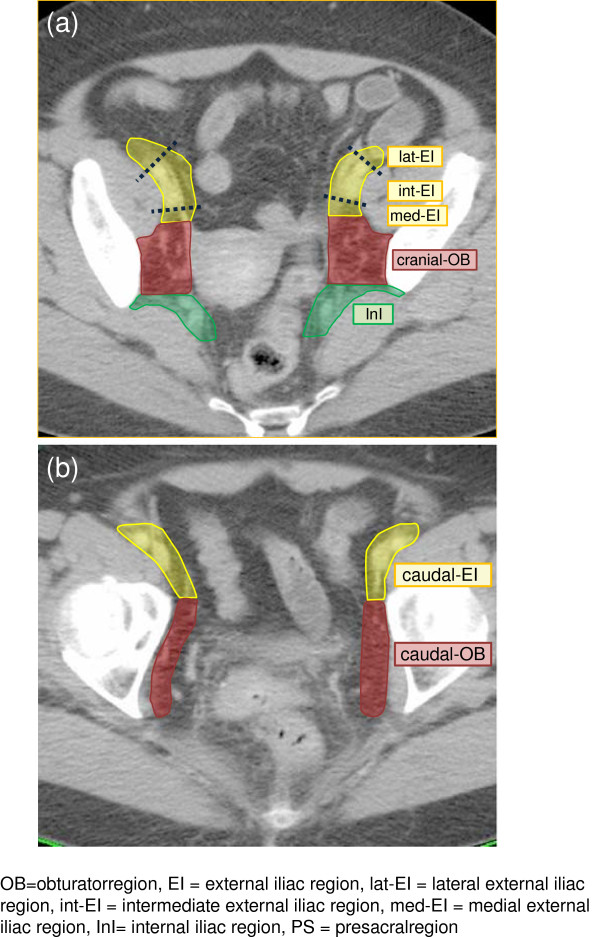
Atlas of the CTV nodes: regions and sub-regions. Middle-level of pelvis' for (a), and 'low-level of pelvis' for (b).